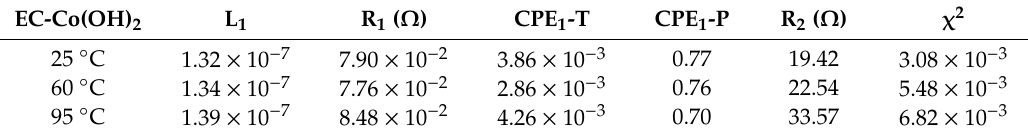
Figure 10. Nyquist diagram for the symmetrical EC at different synthesis temperatures: ( a ) high- frequency region; ( b ) equivalent circuit for the fitted experimental data. Table 5. Experimental data of potentiostatic electrochemical impedance spectroscopy (PEIS) fixed